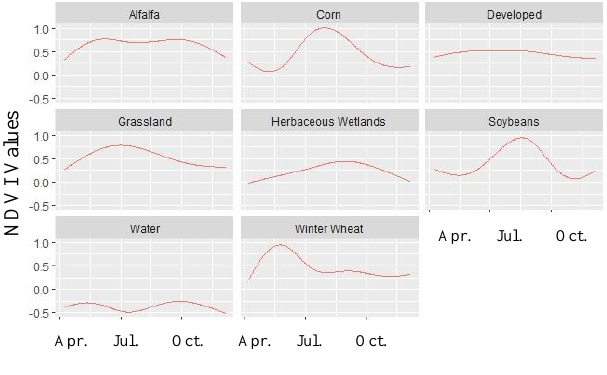
Figure 4. Time series of NDVI